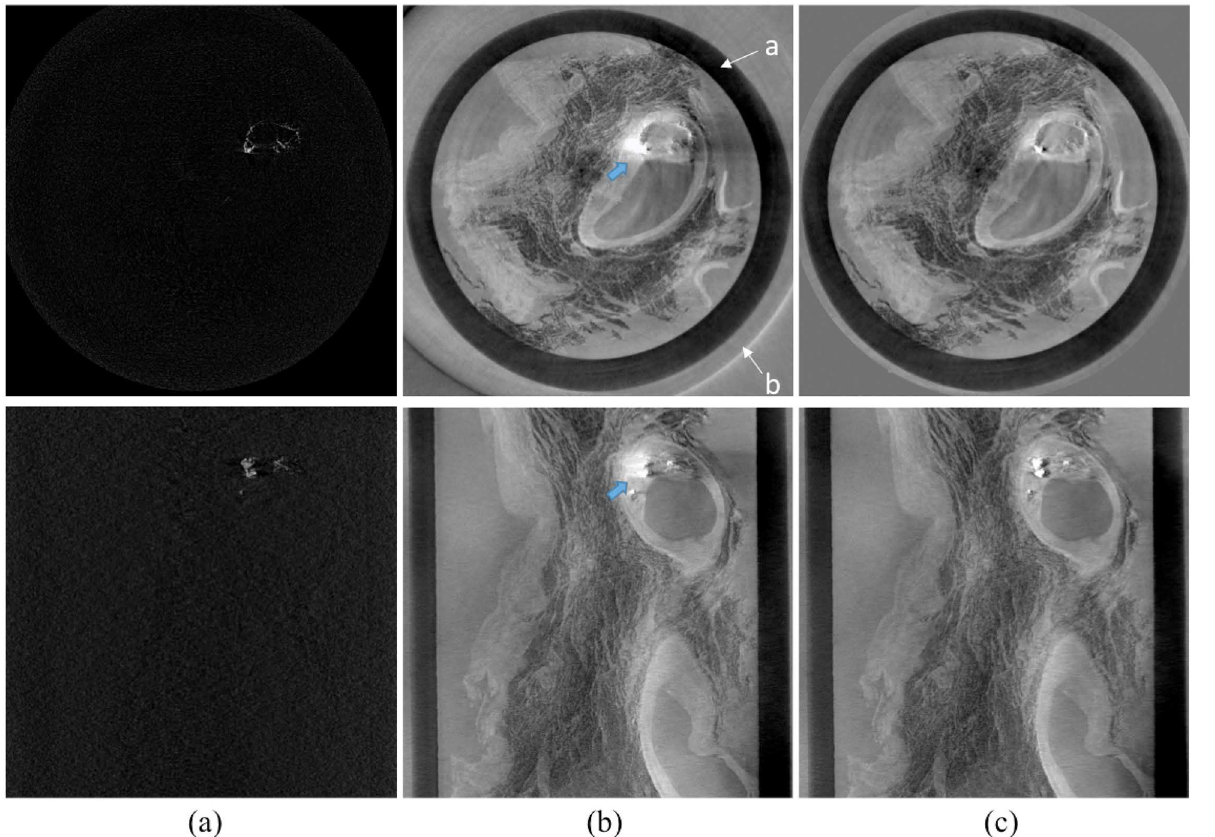
Fig 8. Coronary artery specimen in cross-sectional (top) and longitudinal (bottom) cut planes. Absorption-contrast images (a), phase-contrast images with calcification artefact (b), and phase-contrast image using the proposed algorithm (c) are